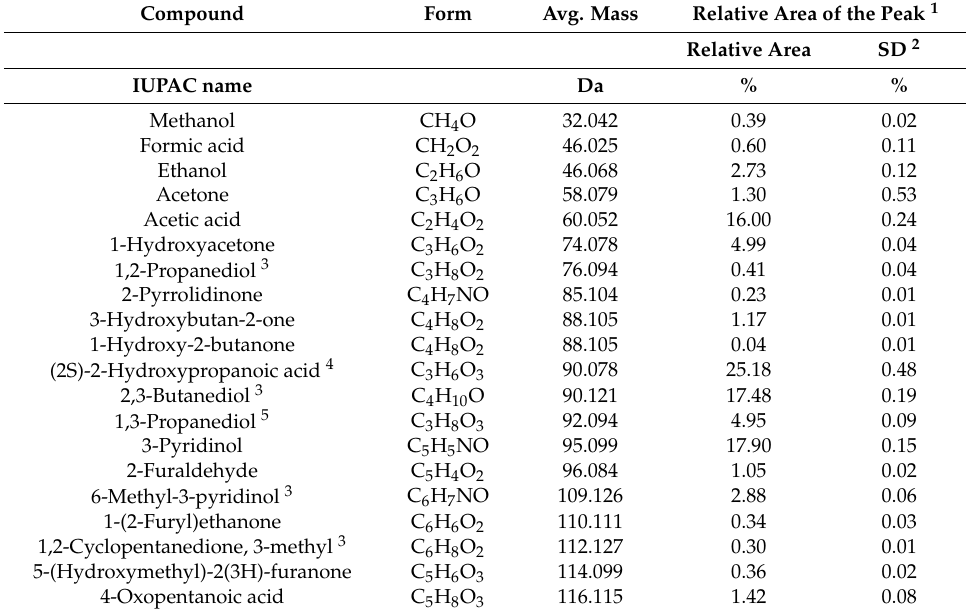
Table 4. Results of the qualitative gas chromatography–mass spectrometry (GC-MS) analysis— compounds detected in the HTC liquid, after de-watering using hydraulic press (IUPAC names from official online database of Royal Society of Chemistry